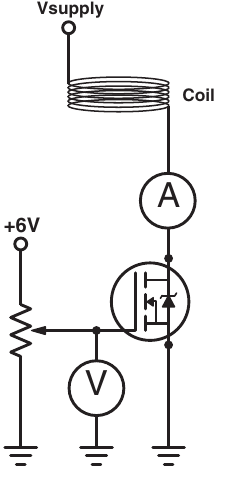
FIG. 4. Voltage-controlled electromagnet circuit used for Ac- tivity 3. The component labeled “ A ” is the ammeter used to measure the current through the coil and the component labeled “ V ” is the voltmeter used to measure the gate to source